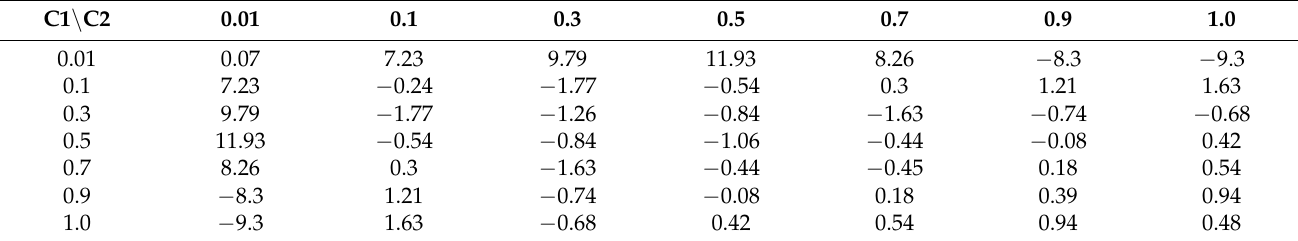
Table 7. The deviation between the membrane impedance R m and the model resistance R m model ( Ω cm 2